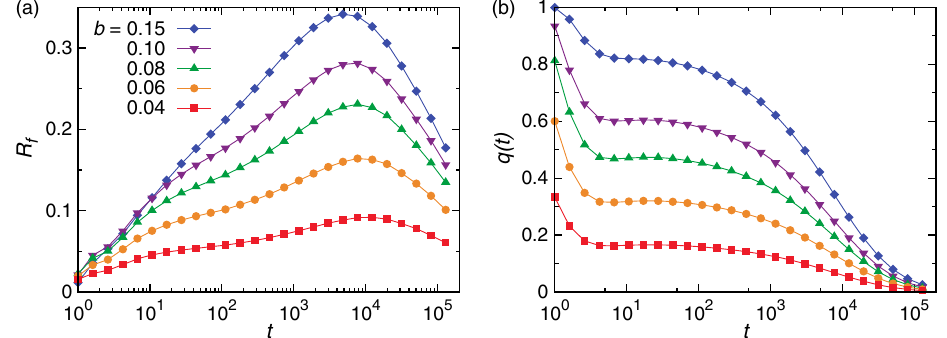
. Note that here all quantities are from direct motions without p; Ψ 6